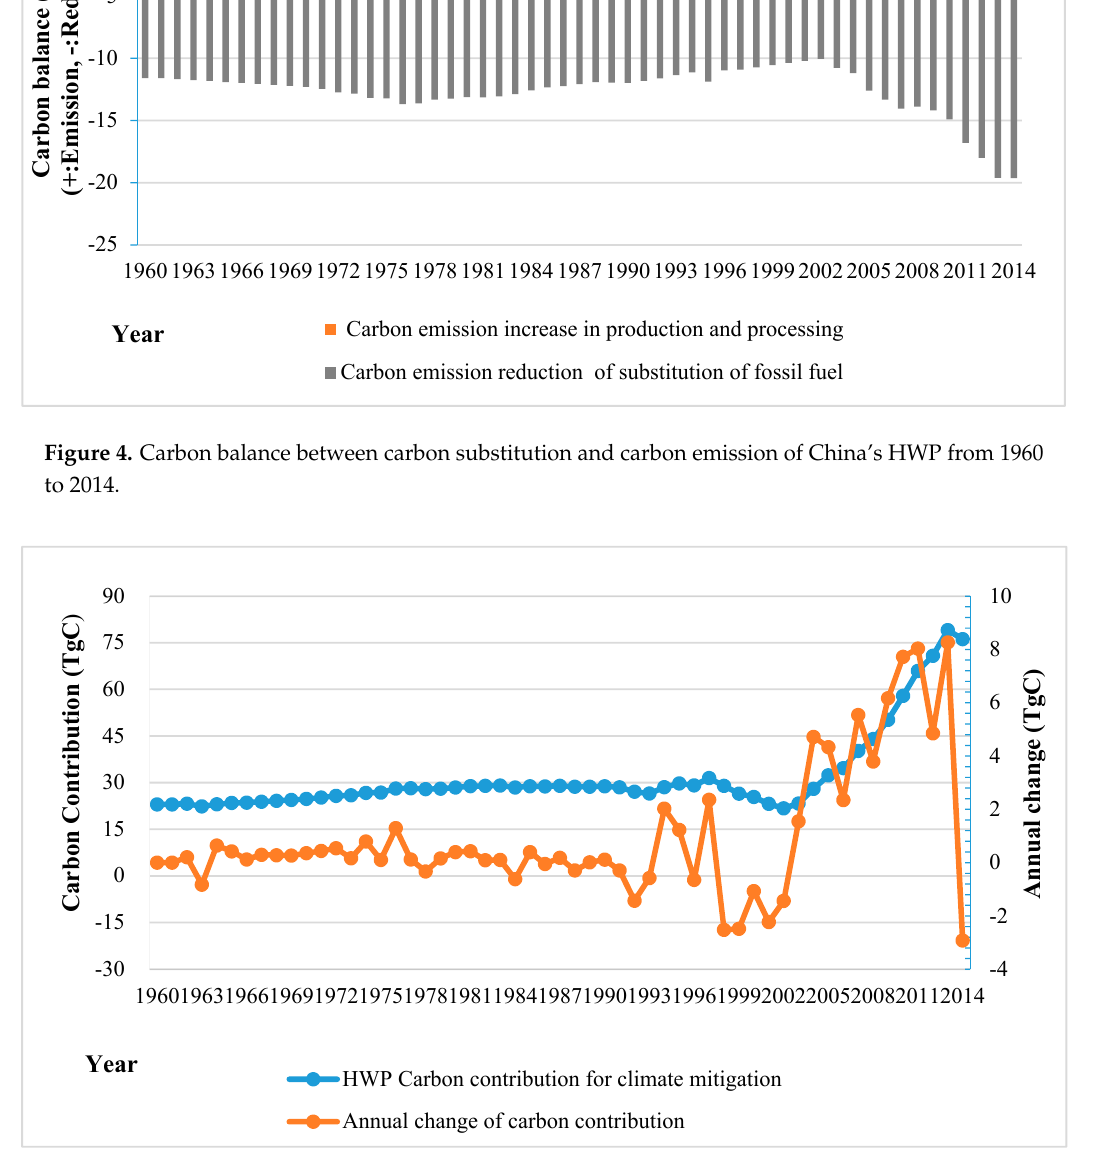
Figure 5. Carbon contribution of HWP for climate mitigation in China from 1960 to 2014.